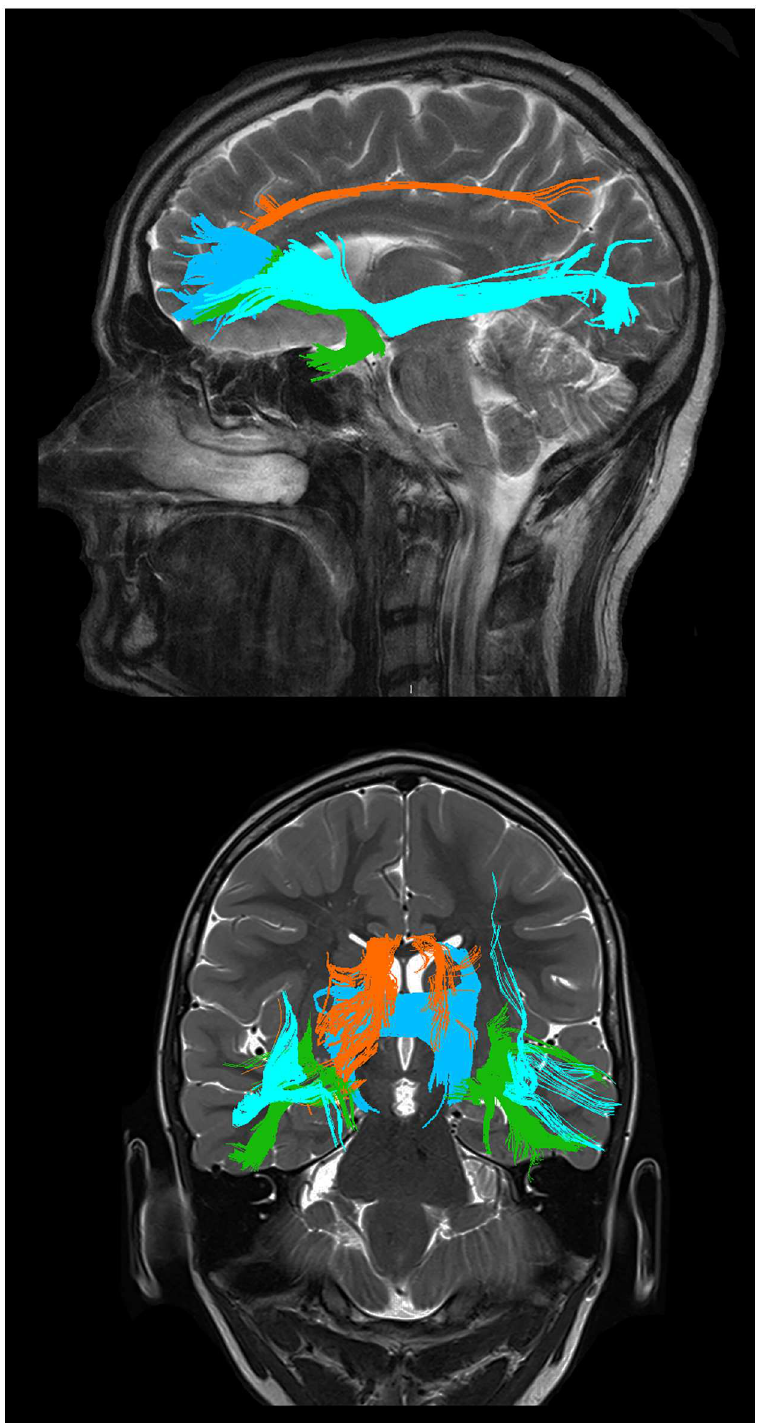
Fig 1. Graphical representations of the tracts studied. Sagittal (upper) and coronal (lower) view. The uncinate fasciculus (green), the anterior cingulum(orange), the inferior frontooccipital fasciculus (light blue) and the forceps minor (dark blue). Tracts are from TrackVis, overlaidon high resolutionimages for illustrative purposes.